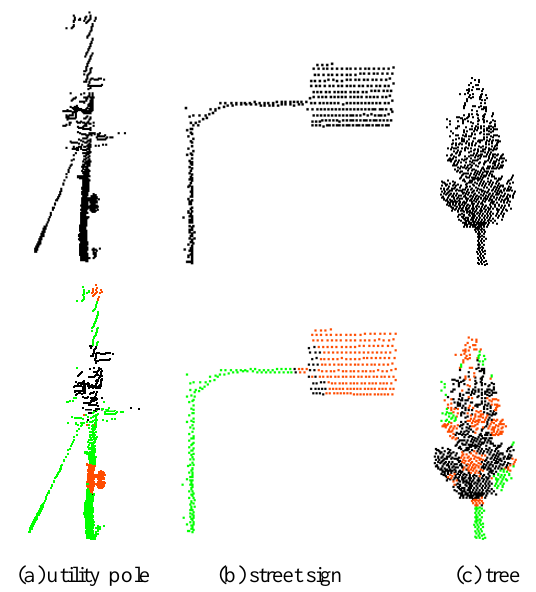
Figure 5. Result of the point classification (green: points on the pole-like object, orange: points on the planar object, black: points on